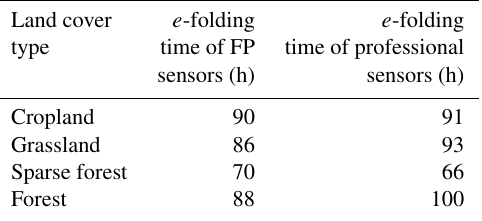
Table 2. The e -folding times for FP and professional sensors, de- pending on the different land cover